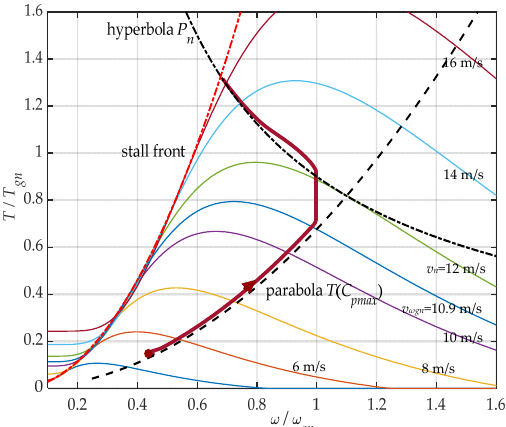
Figure 15. Quasi-static trajectory drawn by the WT state variables ( ω , T ) for the linearly increasing wind speed profile shown in Figure 14.